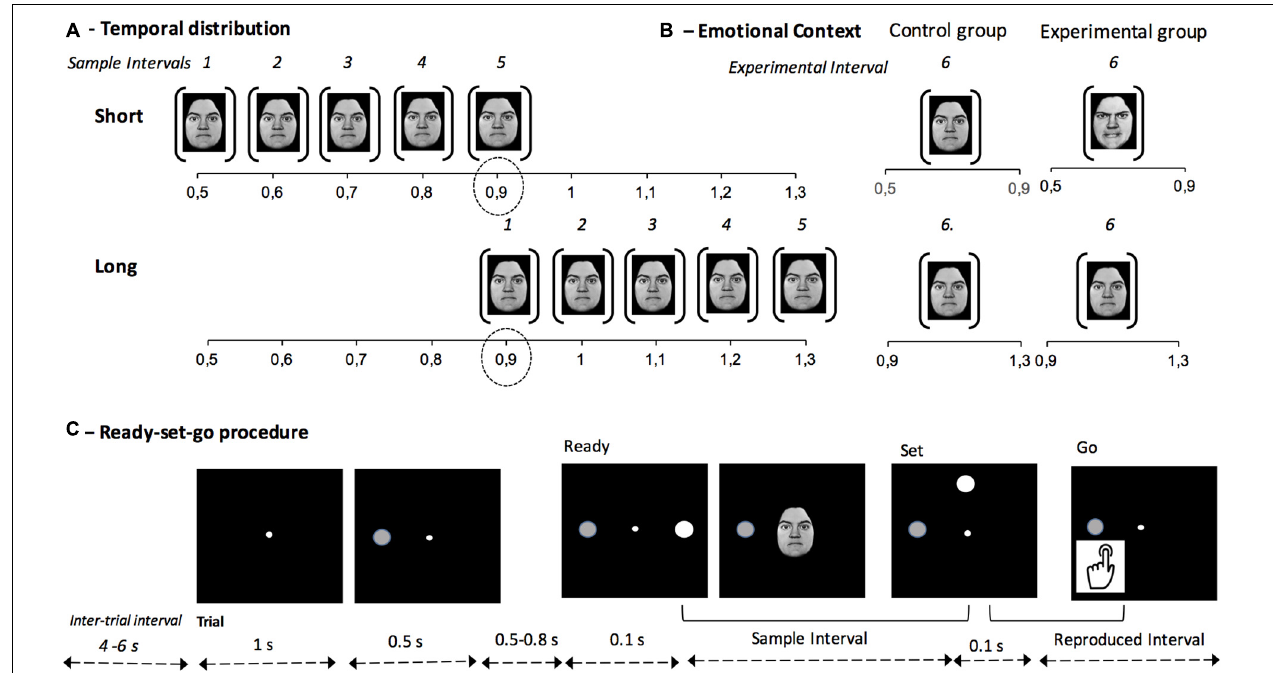
FIGURE 1 | Experimental design of the emotion-modified version of the ready-set-go procedure. (A) Temporal distribution description according to the Short vs. Long condition. The interval of 0.9 s is circle in dotted line because it is common to both temporal distributions. (B) Operationalized Emotional Context as a function of temporal distribution (Short vs. Long) and group condition [Control vs. Experimental (i.e., Emotion)]. (C) Detailed description of the ready-set-go general task, with a trial example.